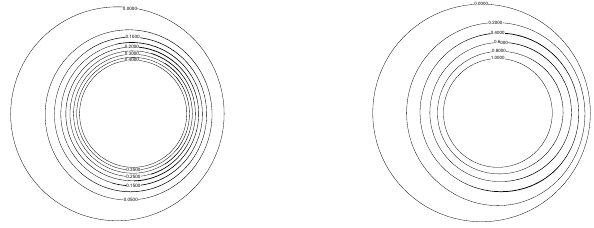
Figure 7. Stream function (left) and u θ (right) results for Re =100 and ε = 0 . 3 . Outer wall is stationary.